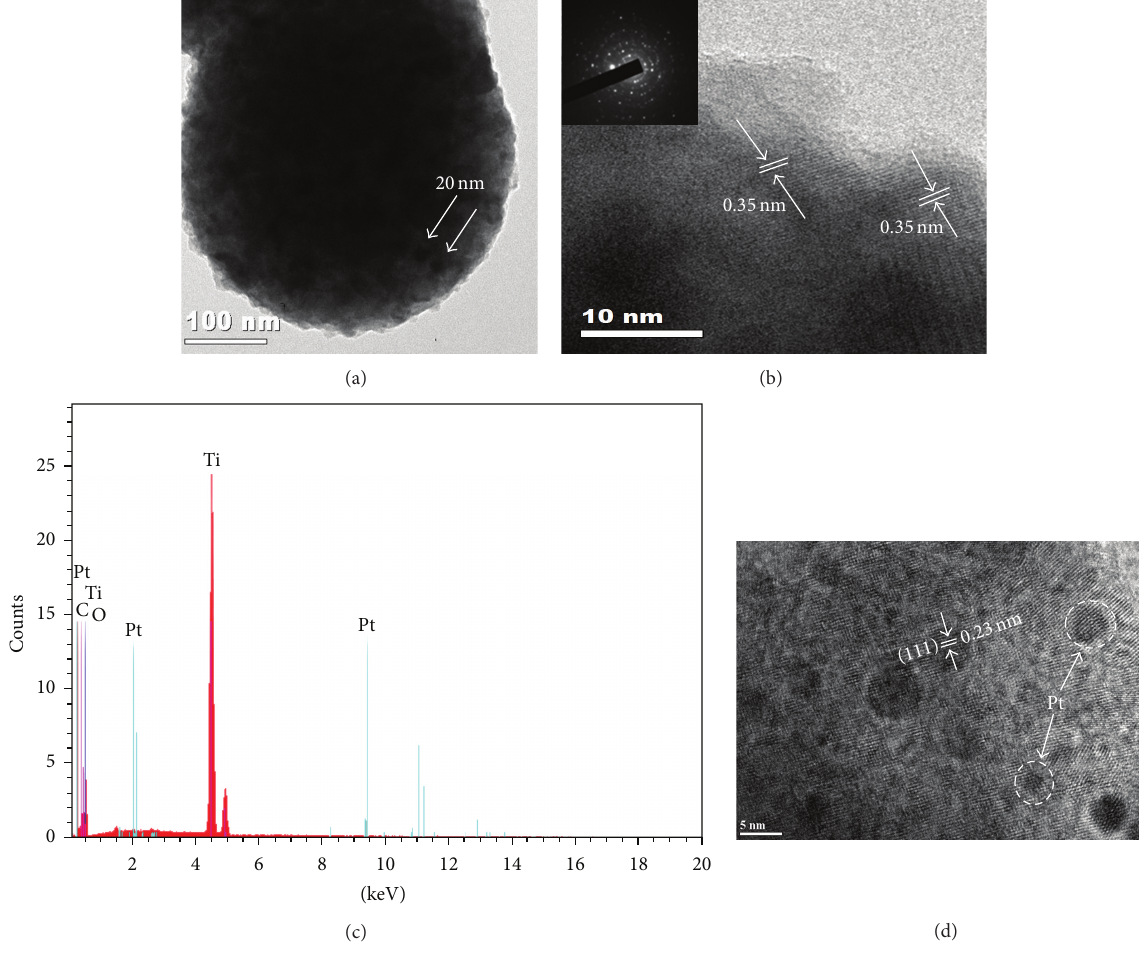
Figure 3: (a) Representative TEM and HRTEM images of the material: (a) TEM image of 0.4 wt% Pt-C/TiO 2 ; (b) HRTEM image of 0.4 wt% Pt-C/TiO 2 ; inset is the SAED pattern; (c) EDX spectrum of the composite; (d) HRTEM image of 1.2 wt%Pt-C/TiO 2 .